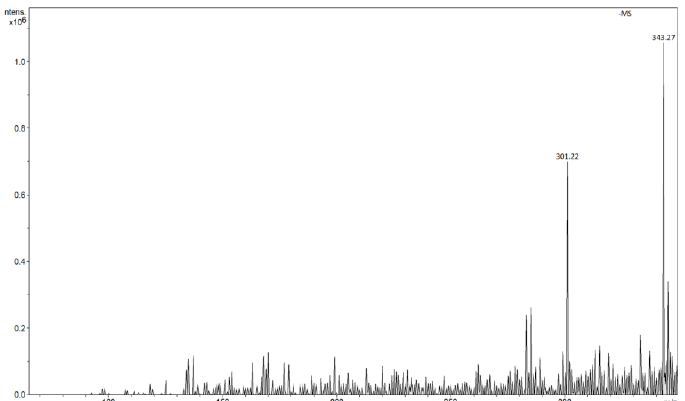
Figure 11. FAPA spectrum of Q-MIP after concentration of quercetin from solution of capers ( m/z 301 [M − H] − ).